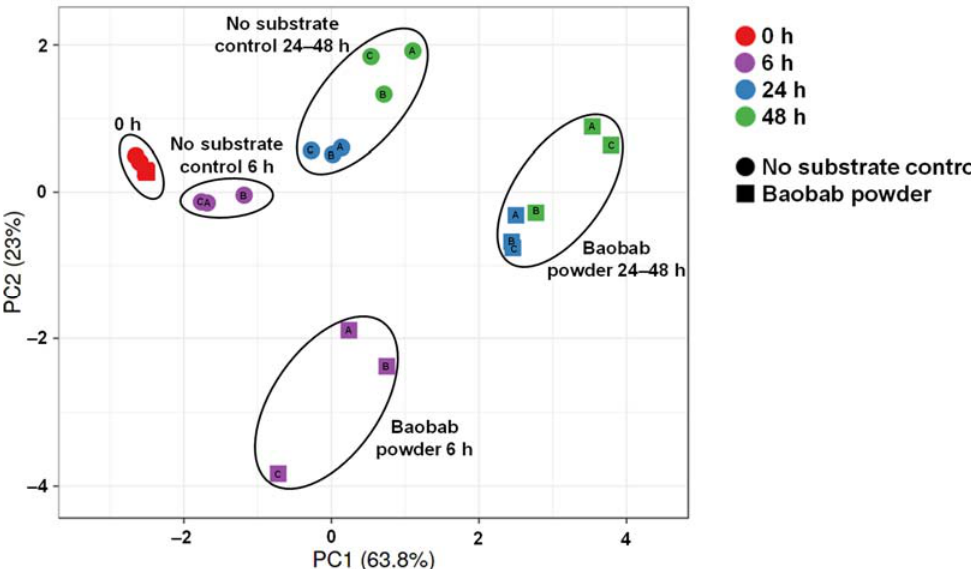
Figure 2. Principal component analysis (86.8%) of the metabolic activity data recorded along the 48 h incubations (pH, gas, acetate, lactate, propionate, butyrate, bCFA). Different symbol shapes indicate different conditions (‘no substrate control’ vs. baobab fruit pulp powder), while different colors reflect different timepoints. Letters inside symbols refer to the respective donor (A, B, or C).